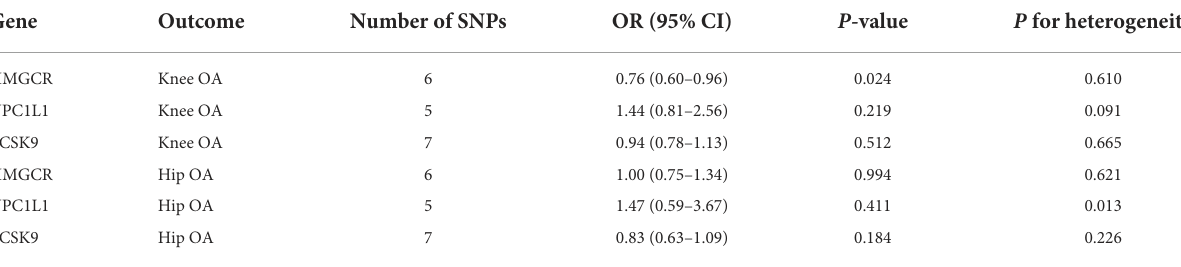
TABLE 3 Estimates of the effect of LDL-C on OA risk using SNPs in specific genes. Gene Outcome Number of SNPs OR (95% CI) P -value P for heterogeneity HMGCR